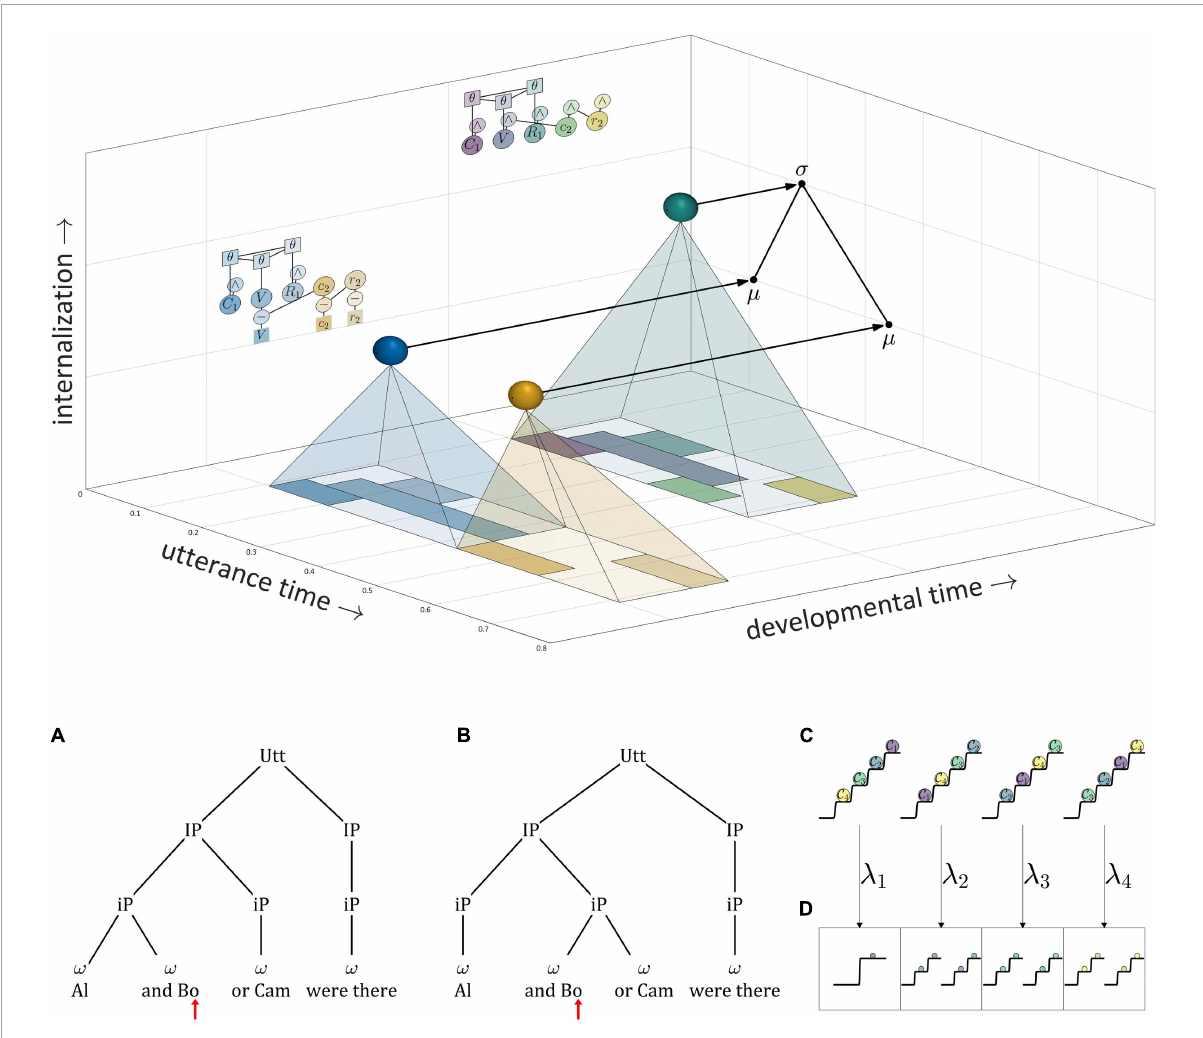
FIGURE14 (Top) Visualization of the holographic hypothesis, for a CVC form. In an early stage of development, control over the post-vocalic constriction is based entirely on sensory feedback. Phonological patterns learned in this stage of development are described with moraic structure. In a later stage of development, control has been internalized, and phonological patterns learned in this stage are described with syllabic structure. (Bottom) Hierarchical prosodic structure reinterpreted as variation in attentional modulation of control parameters. (A vs. B) Alternative hierarchical prosodic structures purported to encode a difference in conceptual grouping. Red arrows indicate timepoint discussed in the text. (C,D) In different epochs of concept system selection, self-attention ( λ ) may differ, resulting in differences in temporal